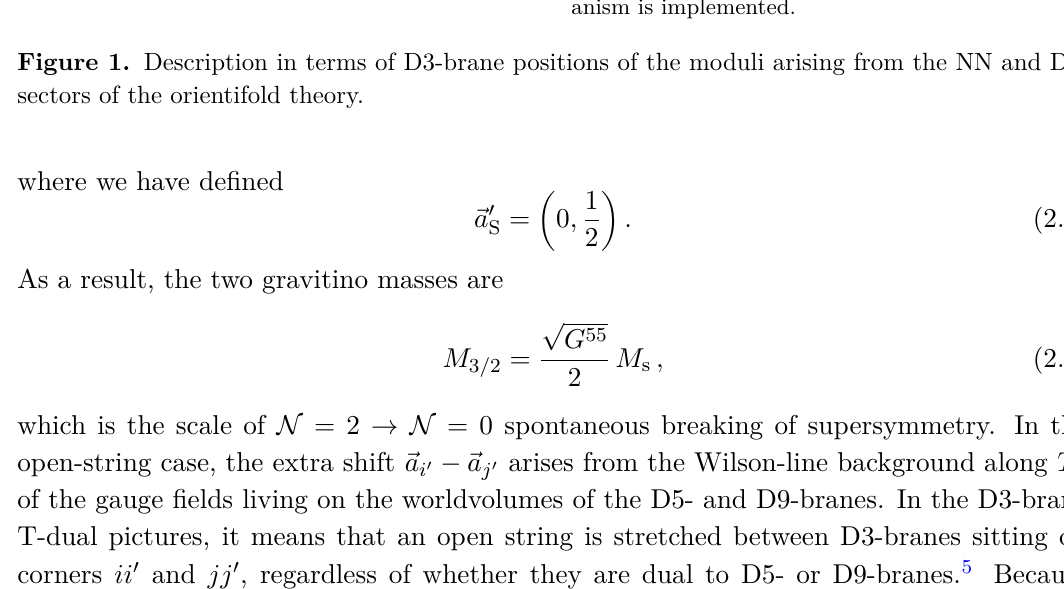
Figure 1. Description in terms of D3-brane positions of the moduli arising from the NN and DD sectors of the orientifold